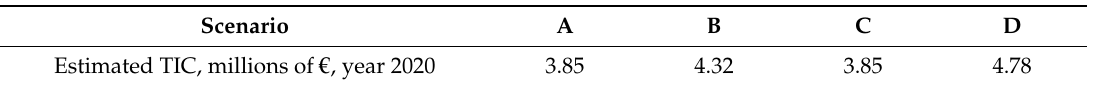
Table 10. Total investment cost for scenarios